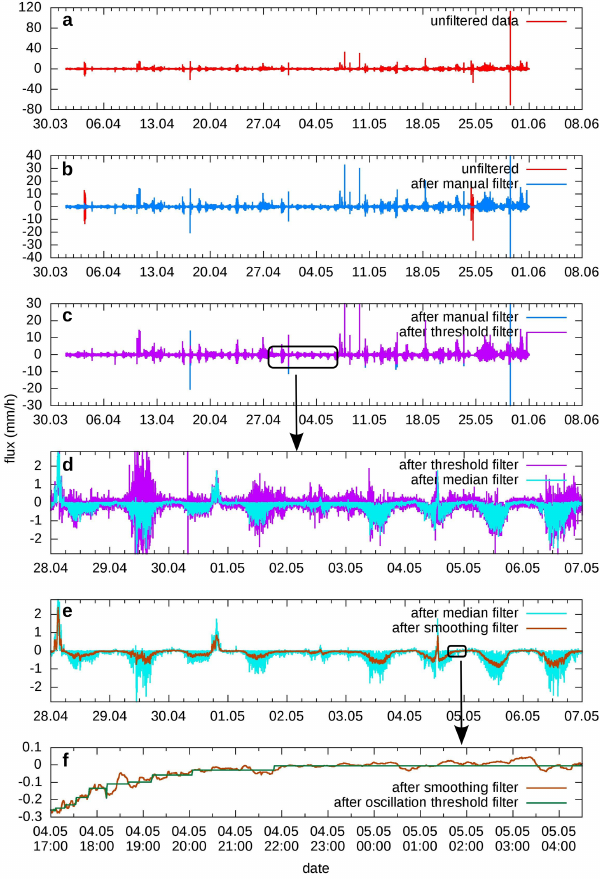
Figure 5. Effect of the different processing steps on the calculated fluxes at the soil–atmosphere interface for one exemplary lysimeter (BL1-L1). After presenting the unfiltered data (a) , the effect of the manual filter (b) , the threshold filter (c) , the median filter (d) , the smoothing filter (e) and the oscillation threshold filter (f) is shown. For (d) , (e) and (f) , zoom levels were increased to illustrate the dif- ferent scales affected by the filtering steps. Please note the different scaling of the